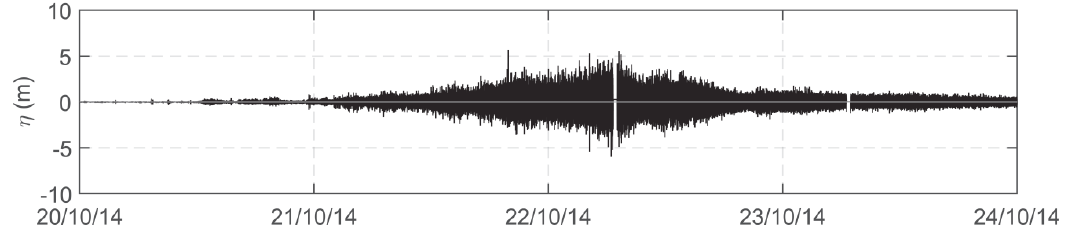
Figure 3. Example of the boat heave time series over a time window of four days, obtained by calculating the instant mean values of the three filtered heave time series as obtained by each GPS antenna.